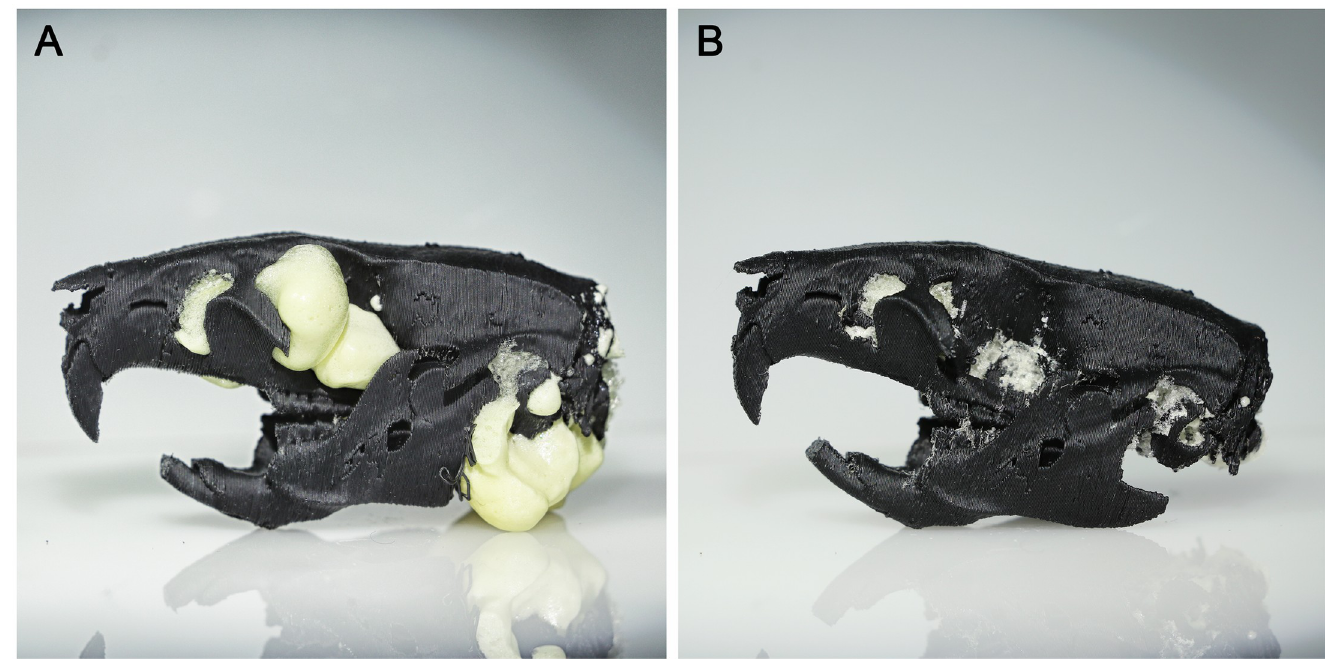
Fig 2. Polyurethane brain manufacturing process. (A) Brain model once dry. (B) Excess of PU foam removed.